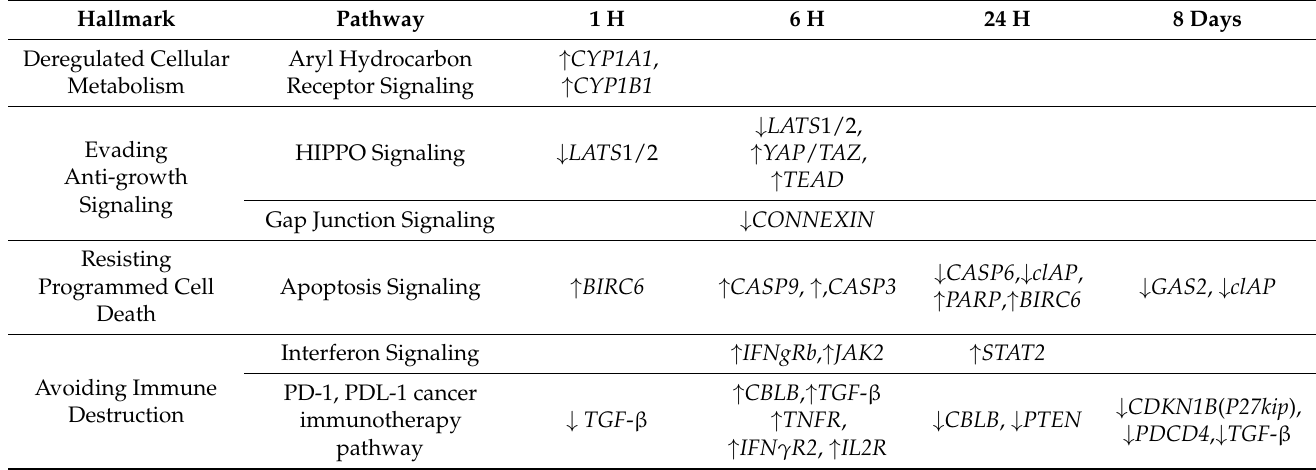
Table 1. Pathway and the hallmark of